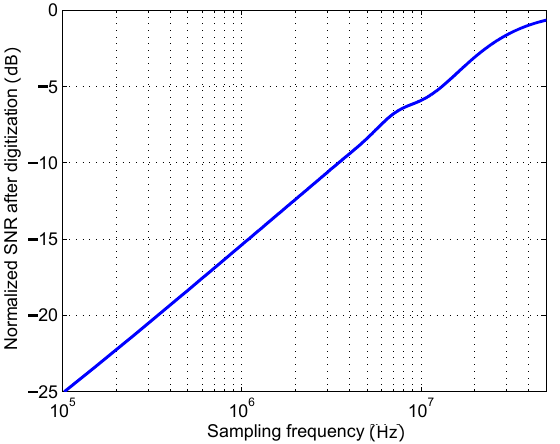
Figure 4. Computation of the normalized SNR after digitization as a function of sampling frequency ( f s )